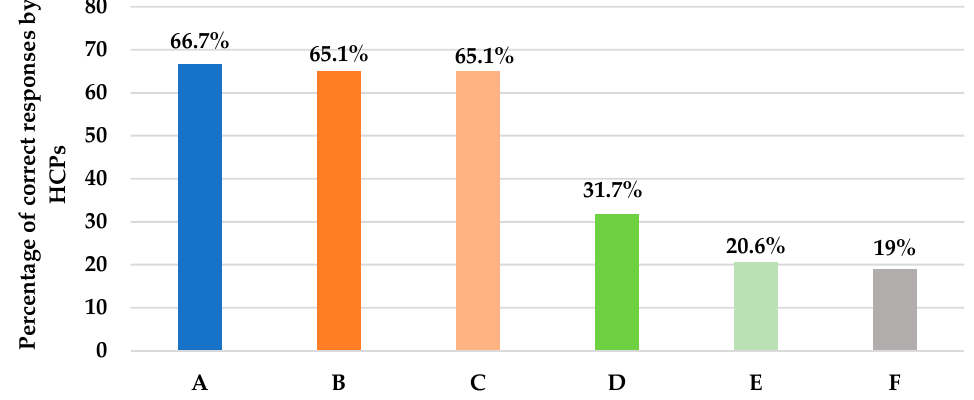
Figure 4. This figure describes the percentage of HCPs’ correct answers to questions assessing the pharmacokinetic properties of antifungal agents. ( A ): Action with fluconazole in CrCl < 30 mL/min; 66.7% answered to adjust the dose. ( B ): Antifungal agent with inherent renal toxicity; 65.1% answered amphotericin deoxycholate. ( C ): Class that does not require renal dose adjustments; 65.1% answered echinocandin. ( D ): Dose of fluconazole in candidemia; 31.7% answered 800 mg LD, then 400 mg. ( E ): Azole that needs adjustment in hepatic impairment; 20.6% answered voriconazole. ( F ): Antifungal agent for invasive candidiasis safe in pregnancy; 19% answered amphotericin B.